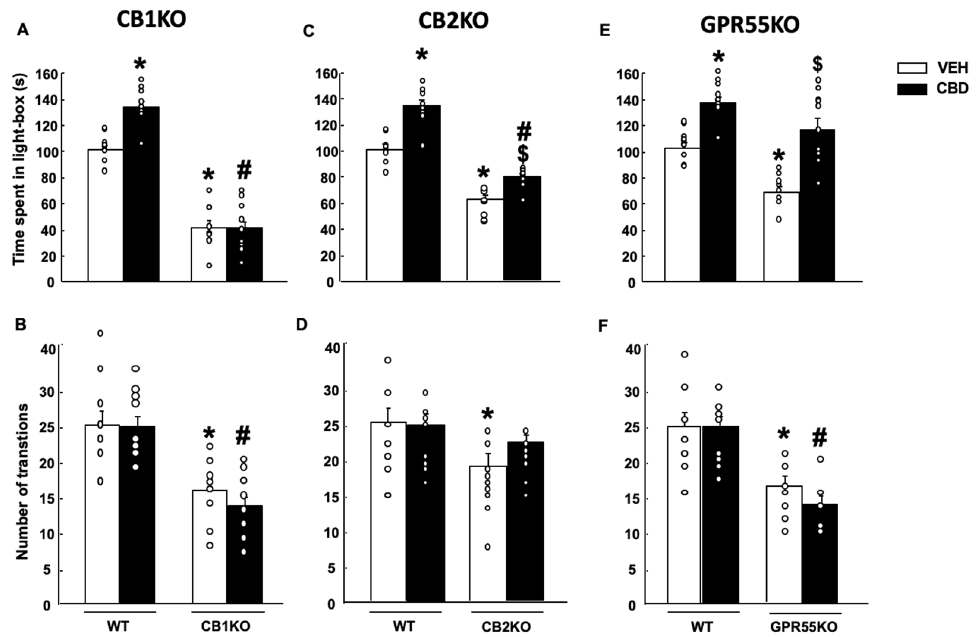
Figure 4. Effects of a single administration of cannabidiol (CBD) at a dose of 20 mg/kg (i.p.) on anxiety-like behaviors in the light-dark box in mice lacking the cannabinoid receptor 1 (CB1KO) ( A , B ), lacking the cannabinoid receptor 2 (CB2KO) ( C , D ), and lacking the G-protein-coupled receptor 55 (GPR55KO) ( E , F ) mice. The behavioral evaluation was developed 1 h and 30 min after the administration of CBD (or vehicle (VEH)). Columns represent the means and vertical lines ± SEM of the time in the lighted box (s) ( A , C , E ) and the number of transitions ( B , D , F ). Results from CD1 VEH and CBD (20 mg/kg) groups have been included for comparative purposes. * Values from groups that were different from wild-type (WT)-VEH treated mice (two-way ANOVA followed by Student–Newman–Keuls test, p < 0.05). $ Values from groups that were different from KO-VEH treated mice (two-way ANOVA followed by Student–Newman–Keuls test, p < 0.05). # Values from groups